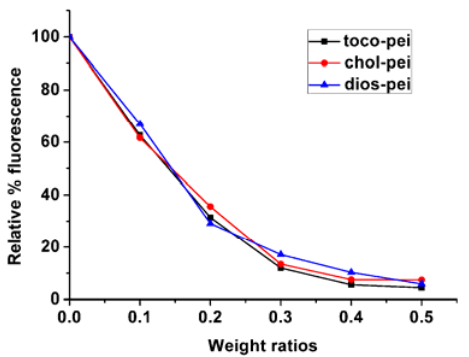
Figure 5. Fluorescence quenching assay using ethidium bromide (EB)/DNA followed by addition of lipopolymers.